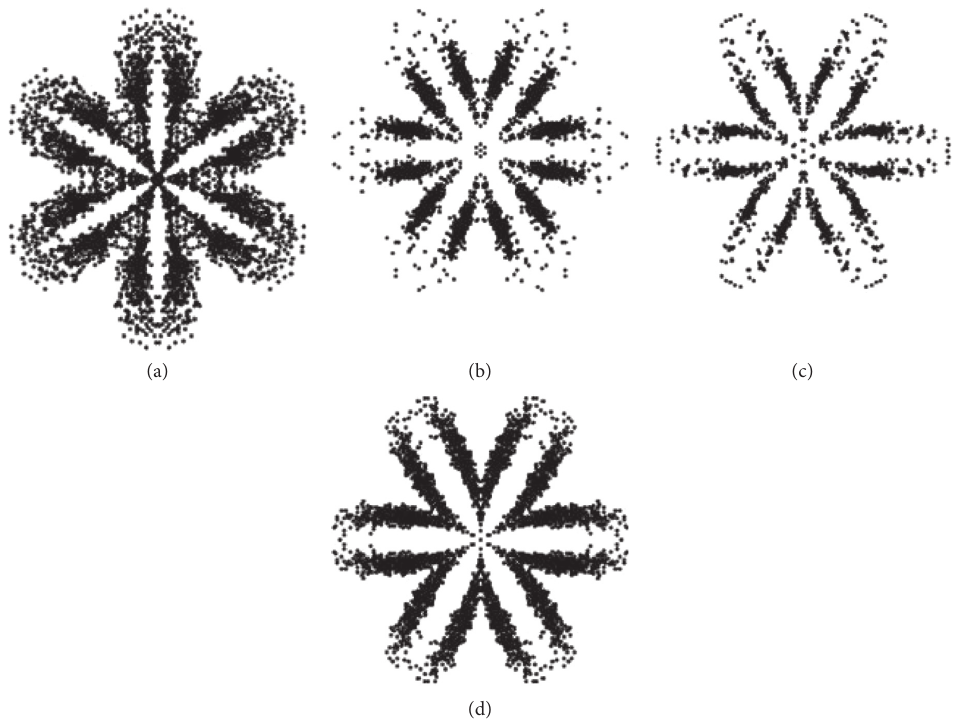
Figure 7: SPCI sample: (a) normal state; (b) inner ring fault; (c) outer ring fault; (d) rolling body fault.